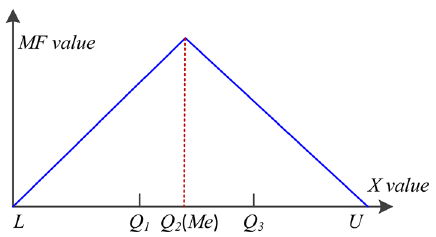
Figure 5. The shapes of attribute sample